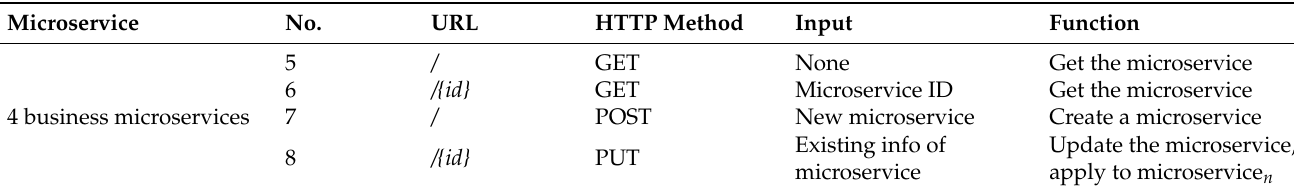
Table 3. Specification of microservices’ API